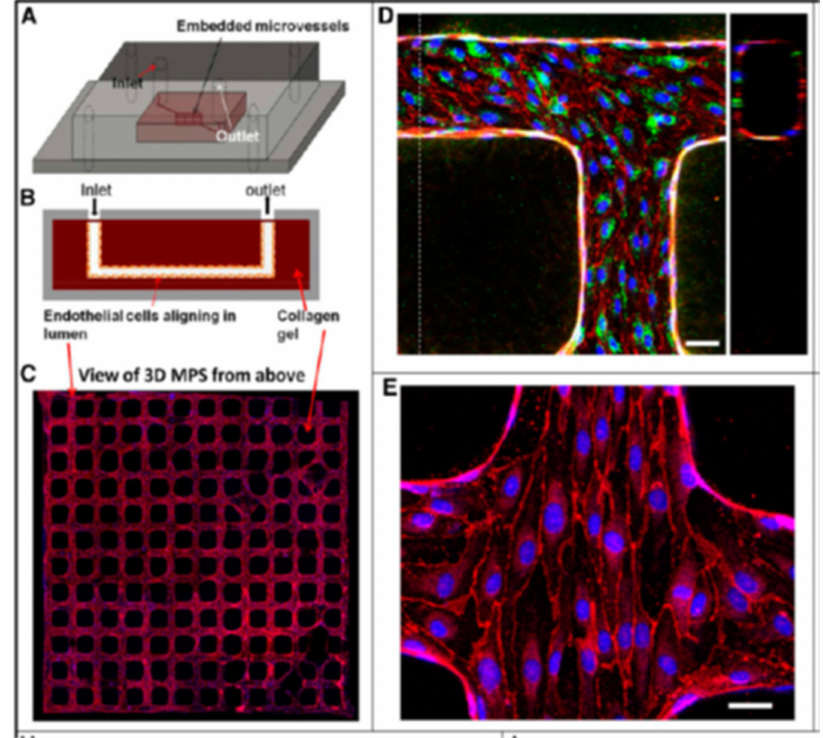
Figure 6. Schematic illustration of 3D the microphysiological system: ( A ) 3D views; ( B ) cross-sections. ( C ) Formation of kidney microvessel networks. Red indicates CD31, and blue indicates nuclei. ( D ) Confocal microscopy image of engineered human kidney microvessel. Red indicates CD31, green indicates vWF,. Scale bar, 50 mm. ( E ) Confocal image of human kidney microvessels at a junction of the network. Red indicates VE cadherin, and blue indicates nuclei. Scale bar, 25 mm. (Reproduced with permission from the American Society of Nephrology. Adapted from Reference